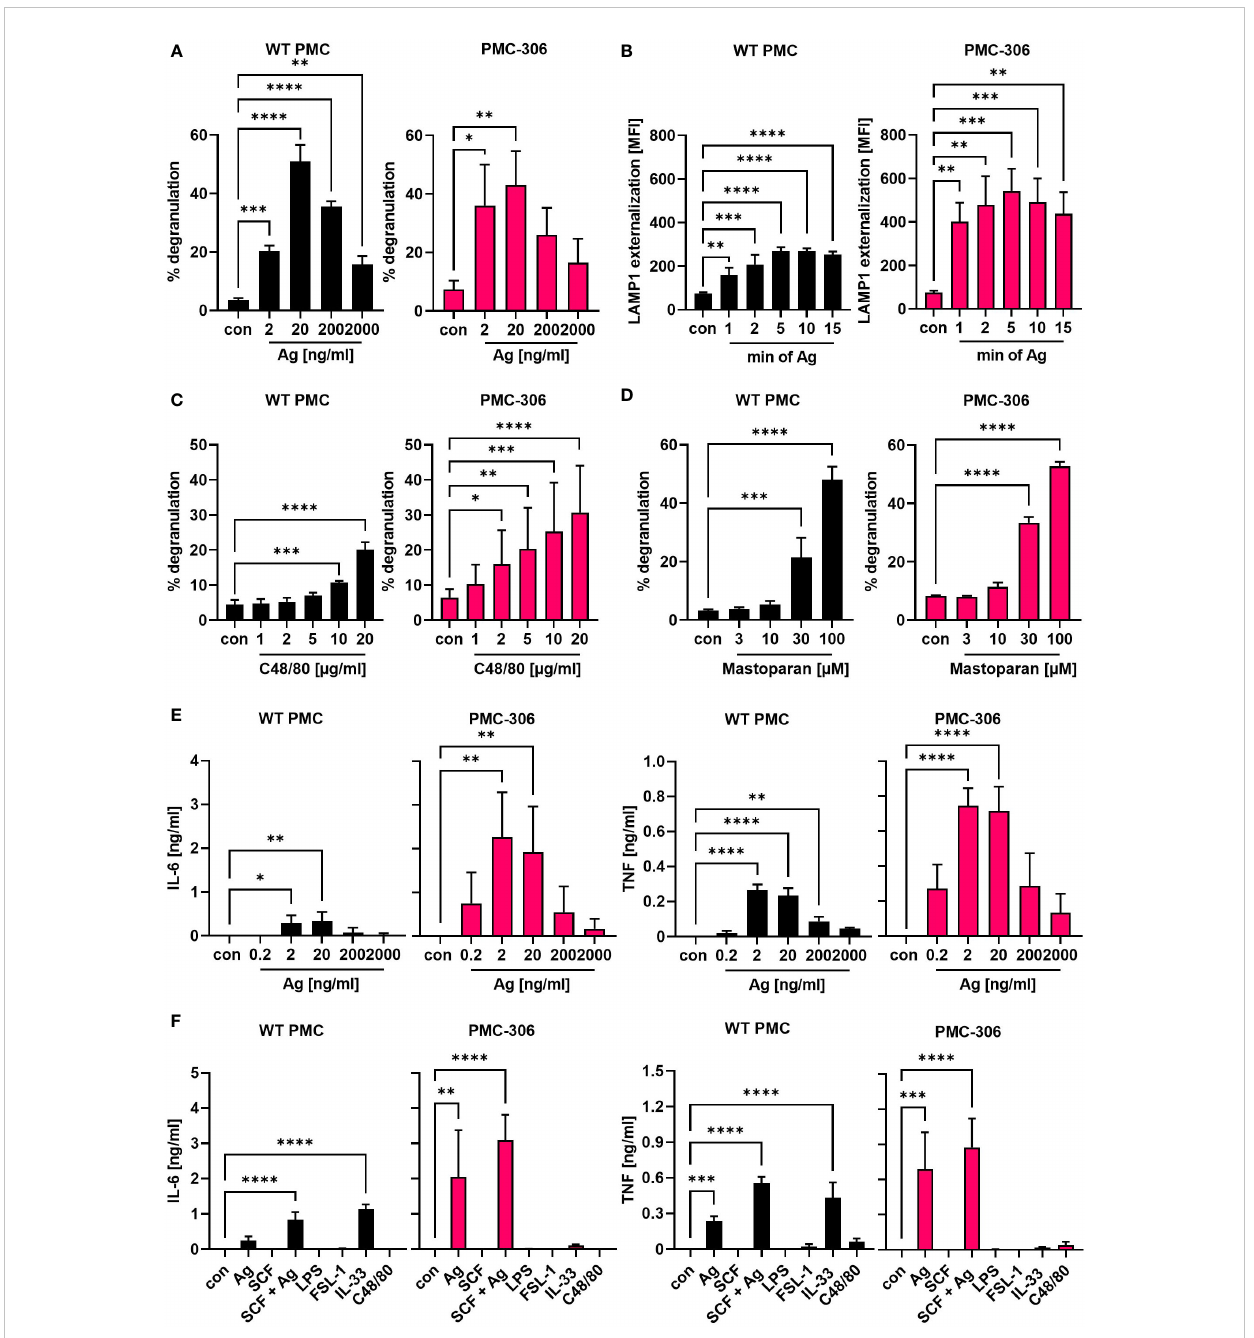
FIGURE 3 The qualitative degranulation and proin fl ammatory cytokine responses of PMC-306 and primary PMCs are similar. (A) Degranulation of primary WT PMCs (left panel) and PMC-306 cells (right panel) in response to increasing Ag concentrations was determined by b -hexosaminidase release assay (n=3). (B) The time-dependent externalization of LAMP1 was determined by quantifying the LAMP1 on the cell surface in FACS analysis as MFI upon stimulation with 20 ng/ml Ag in primary PMCs (left panel) and PMC-306 cells (right panel) (n=3). The degranulation responses of primary PMCs (left panel) and PMC-306 cells (right panel) to increasing concentrations of the MRGPRB2 agonists C48/80 (C) and Mastoparan (D) were determined by b -hexosaminidase release assays (n=3). The secretion of IL-6 [ (E) left ] and TNF [ (E) right ] in response to indicated Ag concentrations was determined by ELISA (n=3). The pro-in fl ammatory cytokine production of primary WT PMCs and PMC-306 to Ag (20 ng/ml) in comparison to other stimuli (SCF: 100 ng/ml, SCF+Ag: 100 ng/ml and 20 ng/ml, LPS: 1µg/ml, FSL-1: 1 µg/ml, IL-33: 10 ng/ml, C48/80: 10 µg/ml) was determined by IL-6 [ (F) left ] and TNF [ (F) right ] ELISAs (n=3). Data are shown as mean +SD. One-way ANOVA followed by Dunnett multiple comparisons test. Stars indicate signi fi cance within one group relative to control. p >0.05 ns, * p <0.05, ** p <0.01, *** p <0.001, **** p